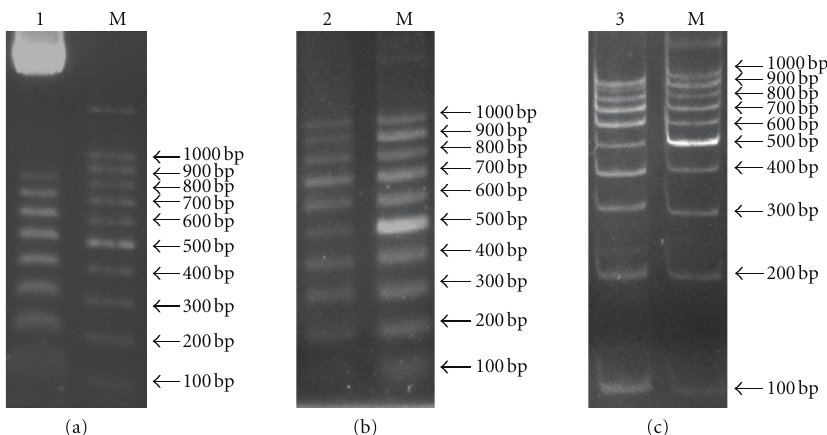
Figure 2: Production of 100bp DNA ladder. (a) The pGEM-800 plasmid was partially digested by Sma I enzyme producing 8 fragments in length of 100–800 bp. (b, c) Electrophoresis of the prepared 100 bp DNA ladder. A 5 µ L (lane 2) or 3 µ L (lane 3) of DNA ladder prepared in the present study and 100 bp DNA marker from Takara (M) were submitted to 2% agarose (b) or 12% acrylamide (c) gel electrophoresis, respectively.